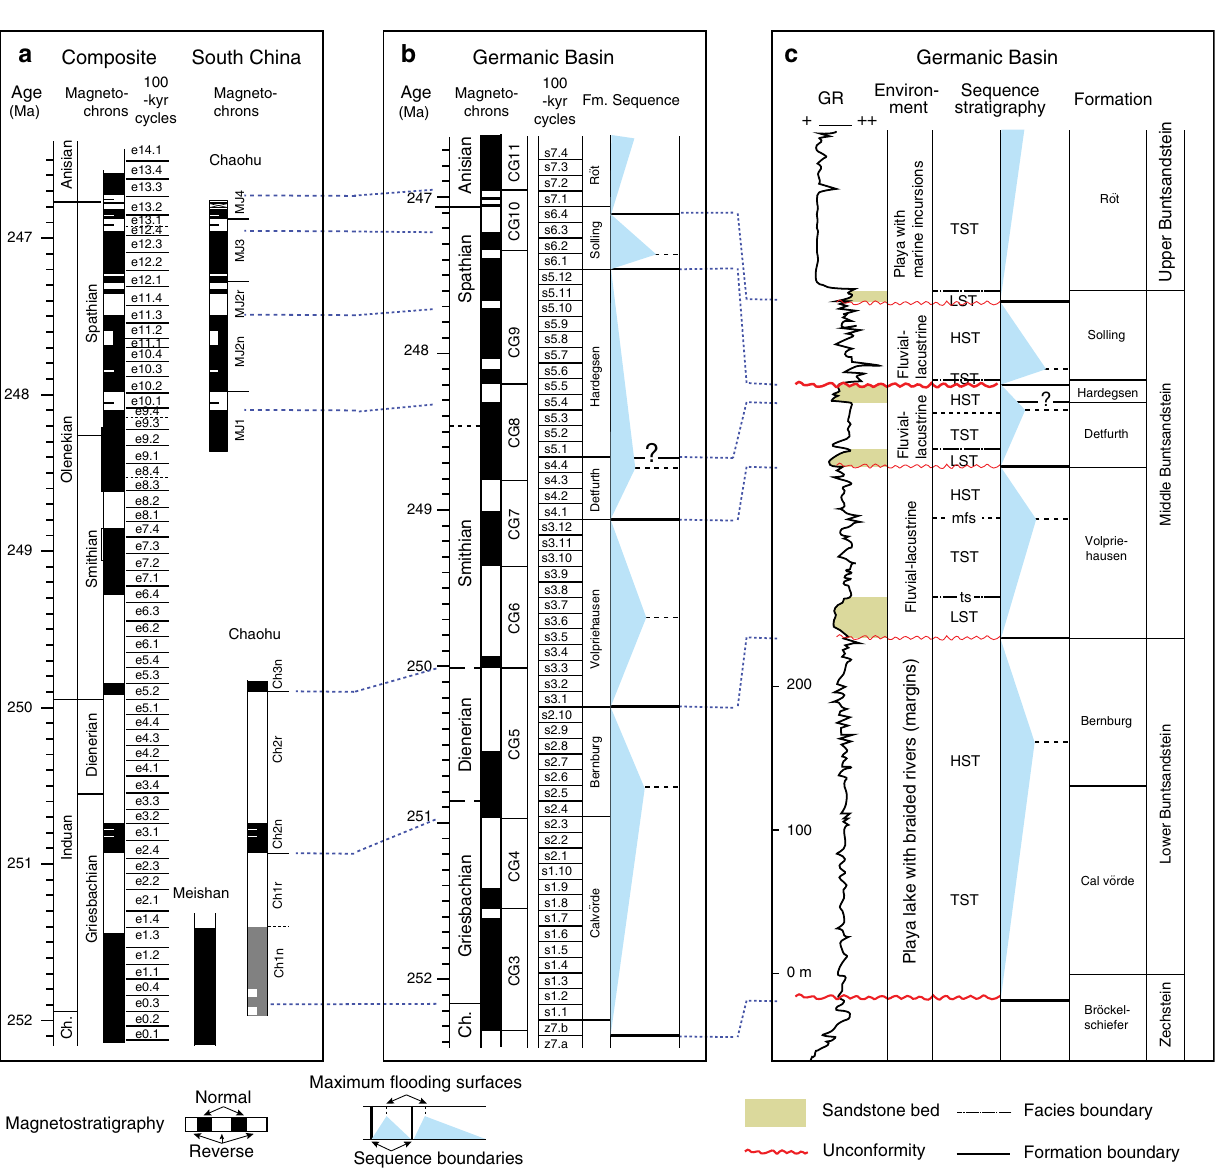
Fig. 5 Sequence stratigraphy of the Germanic Basin. a 405 kyr cycle-calibrated magnetostratigraphy in South China 13 . b 100 kyr cycle calibrated magnetostratigraphy of the Germanic Basin 37,69,70 shown with calibrated Germanic sequences in c . c Sequence stratigraphy of the Germanic Basin 40,41 plotted in the stratigraphic domain. Dashed blue lines indicate formation boundaries in the Germanic Basin. LST: lowstand systems tract. TST: